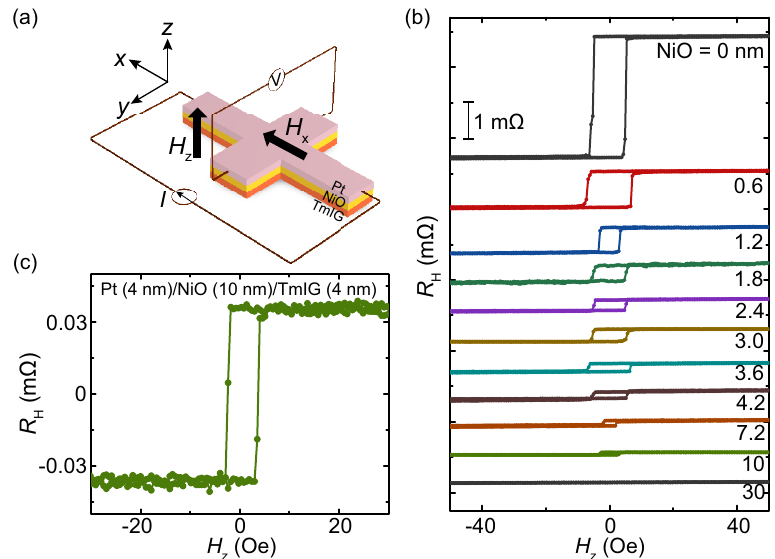
Figure 2. ( a ) Schematic of the setup for the AHE resistance measurement. ( b ) AHE resistance curves of the Pt (4 nm)/NiO ( t nm)/TmIG (4 nm) devices with different NiO thicknesses. ( c ) AHE resistance curve of the Pt (4 nm)/NiO (10 nm)/TmIG (4 nm) device. In the following, we measure the damping-like torque-induced effective field H eff the Pt (4 nm)/NiO ( t nm)/TmIG (4 nm) devices with different NiO thicknesses. An external